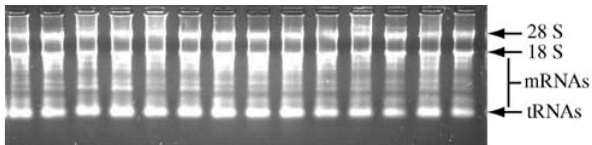
Figure2 -ThequalityofthetotalRNAextractedfromthepituitariesof14 pigs. The samples were run on 1.2% agarose